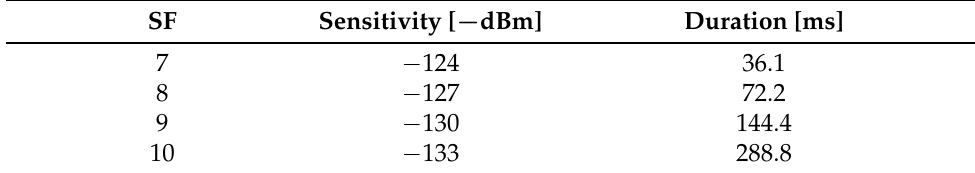
Table 1. Sensitivity and transmission duration according to spreading factors